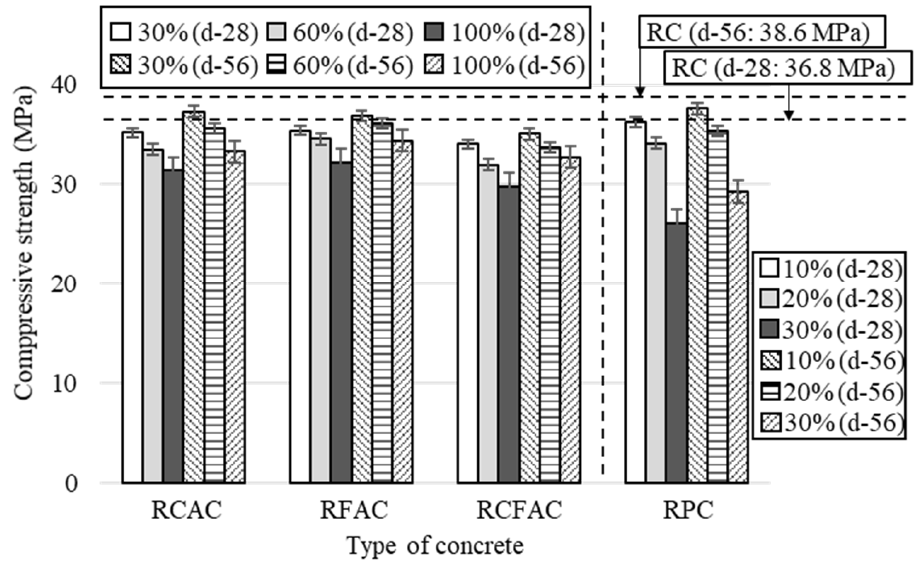
Figure 4. Test results of compressive strength of concretes made of recycled aggregates and recy- cled powder.